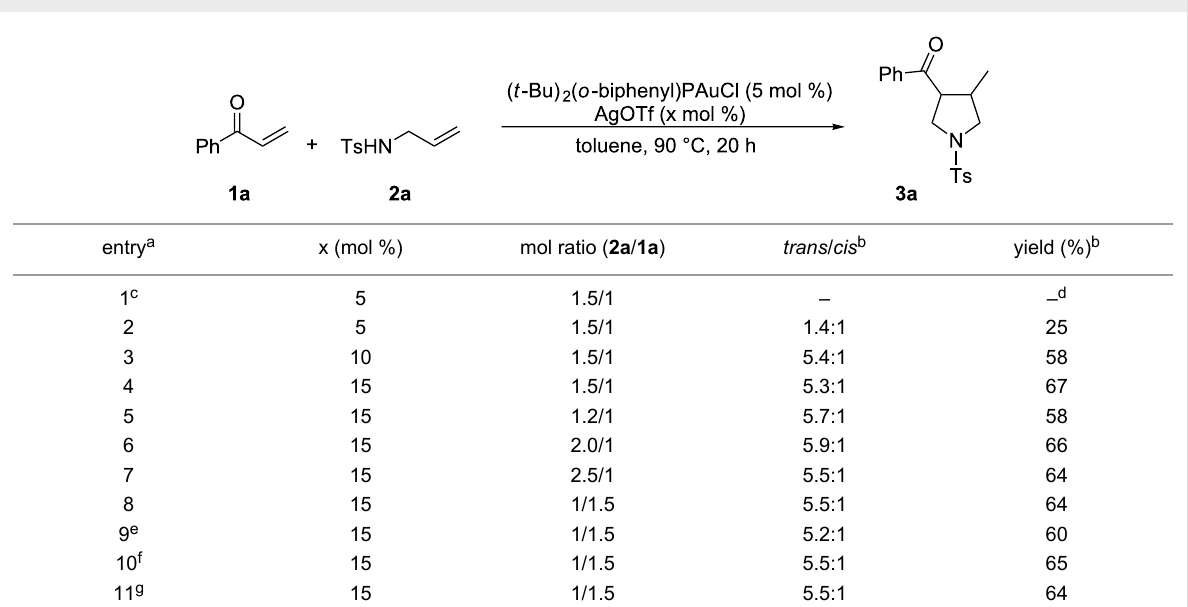
Table 1: The optimization of the reaction conditions.